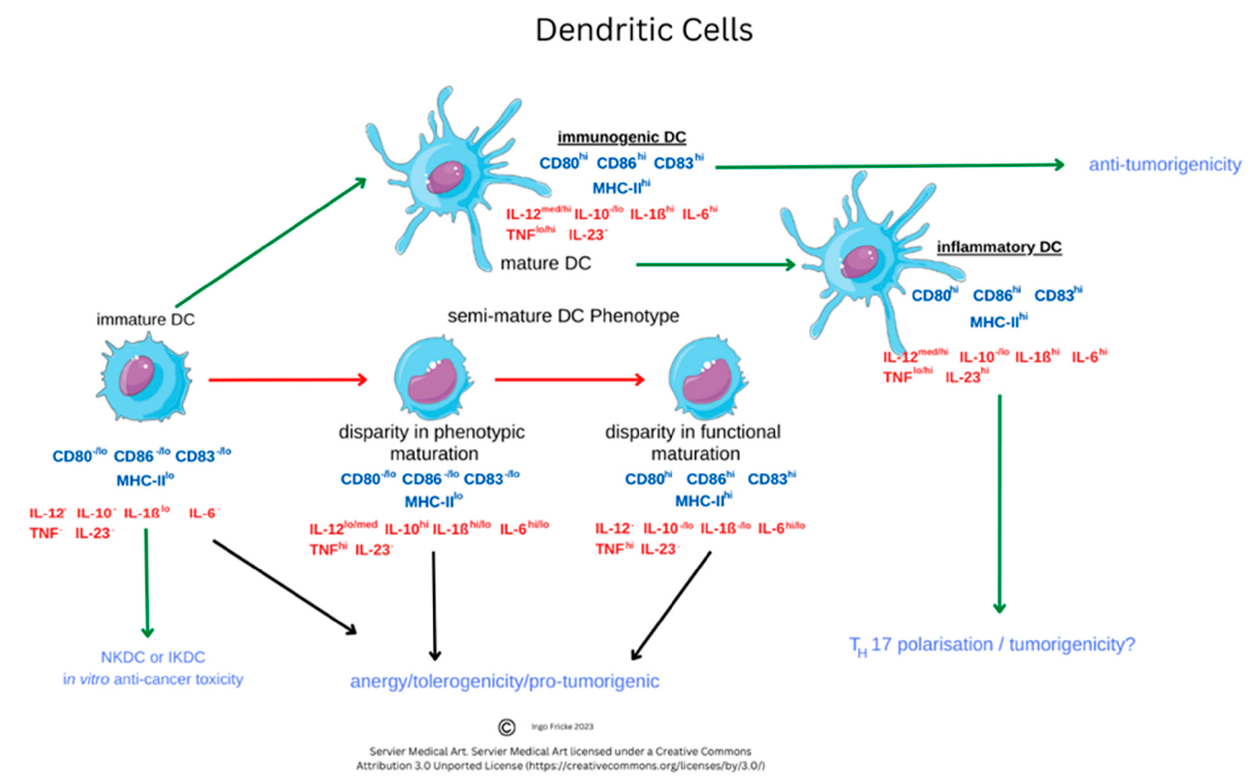
Figure 8. Functional diversity of dendritic cells in maturation.